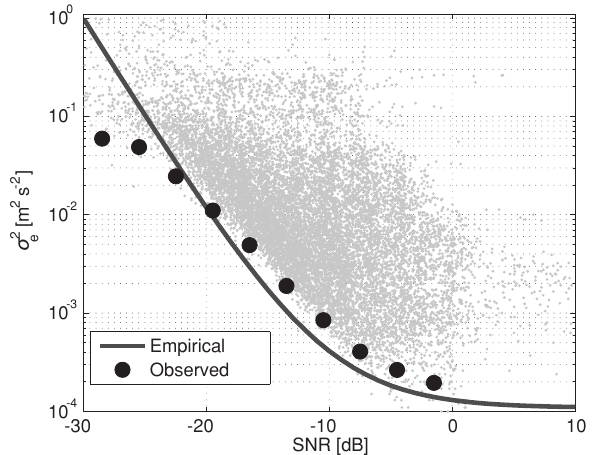
Figure 1. The relationship between the signal-to-noise ratio (SNR) and the radial velocity random error variance ( σ 2 e ). The gray dots show the observed radial velocity variance approximated by the dif- ference between the variance and the autocovariance at one time lag of the radial velocities collected in an experiment in which the lidar was operated with a staring mode at the US National Renewable Energy Laboratory (Wang et al., 2015), and the observed Cramer– Rao Bound (CRB) (filled dark circles) is approximated by the mean of the lowest 5% of the gray dots (Frehlich, 2001). The empirical relationship between the SNR and the CRB is denoted by the dark solid line and is based on Eq. (5) in Pearson and Collier